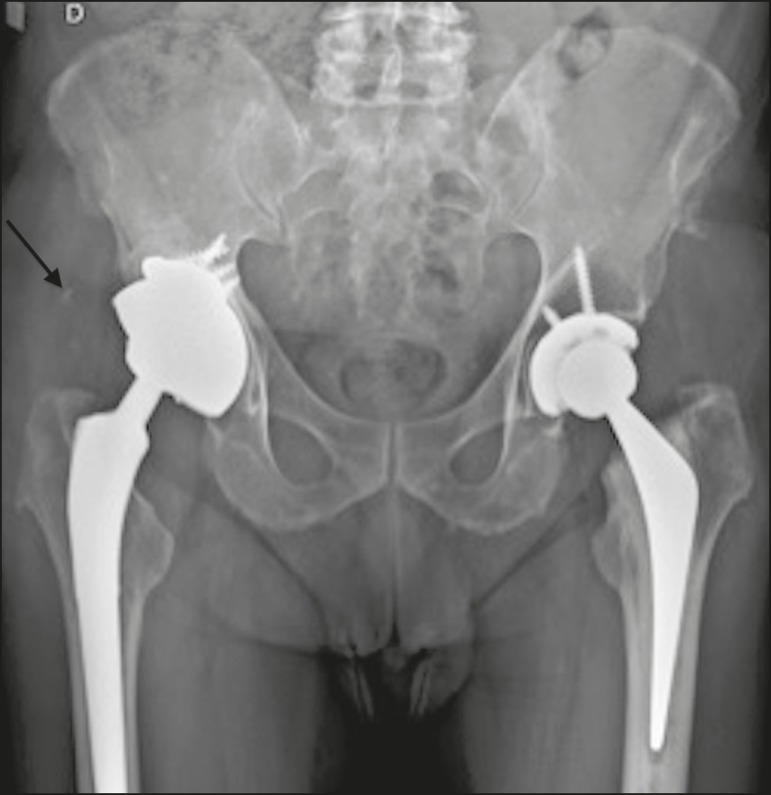
Anteroposterior X-ray of the right hip with grade I heterotopic ossification in the projection of lateral soft tissues on the right (arrow). Total hip arthroplasty in which the acetabular component of the prosthesis was affixed with screws, with no signs of loosening.